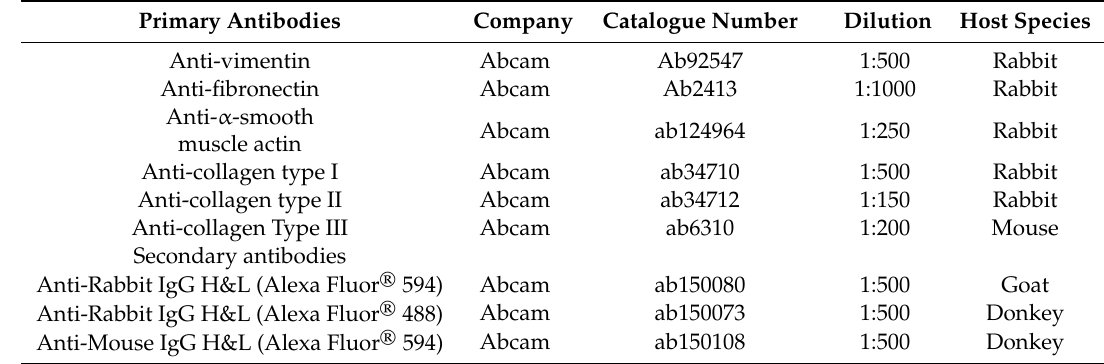
Table 1. List of antibodies used for immunofluorescence